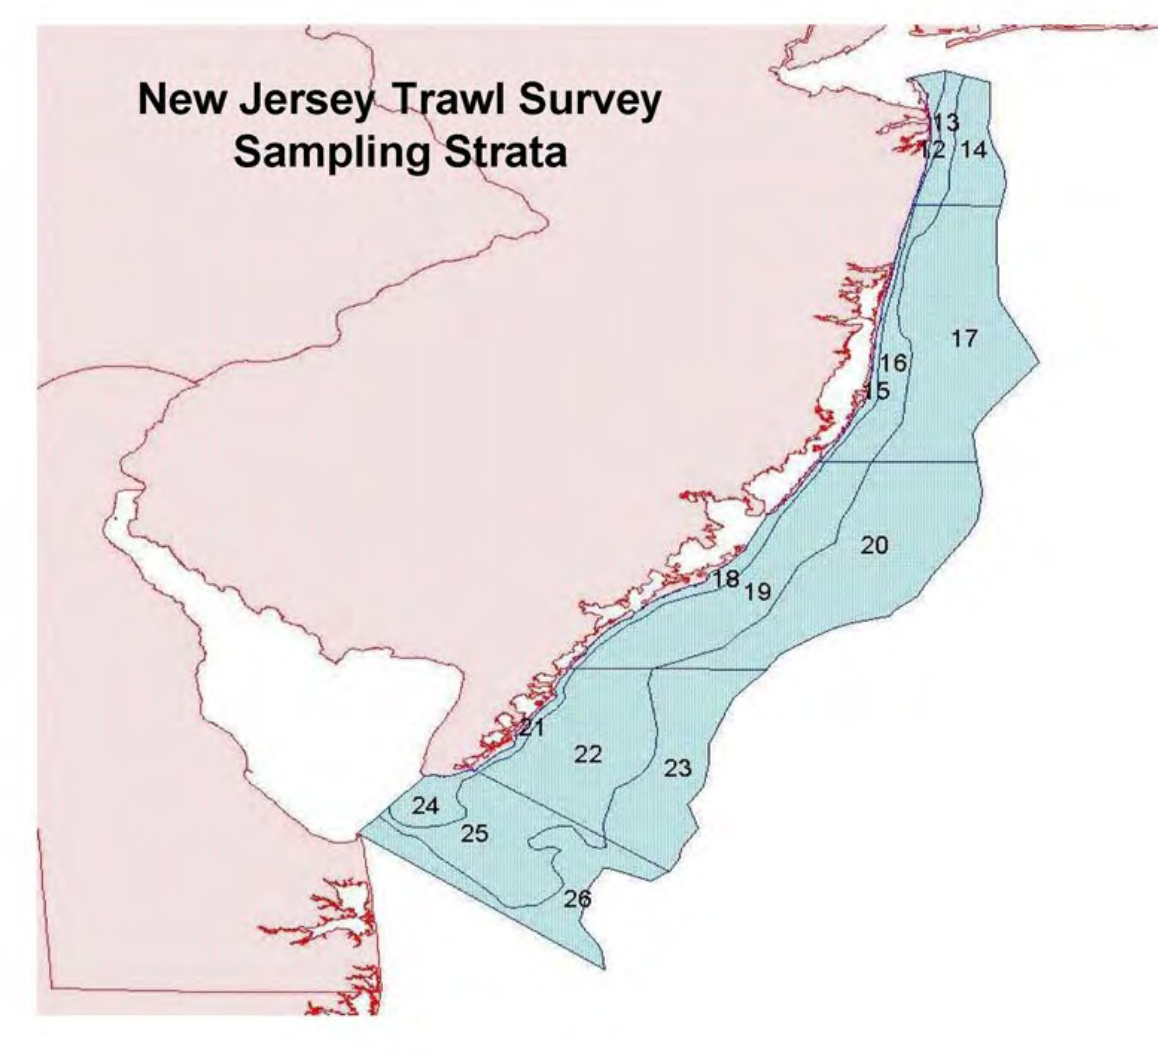
Figure 42. New Jersey Ocean Trawl Survey sampling area with survey strata